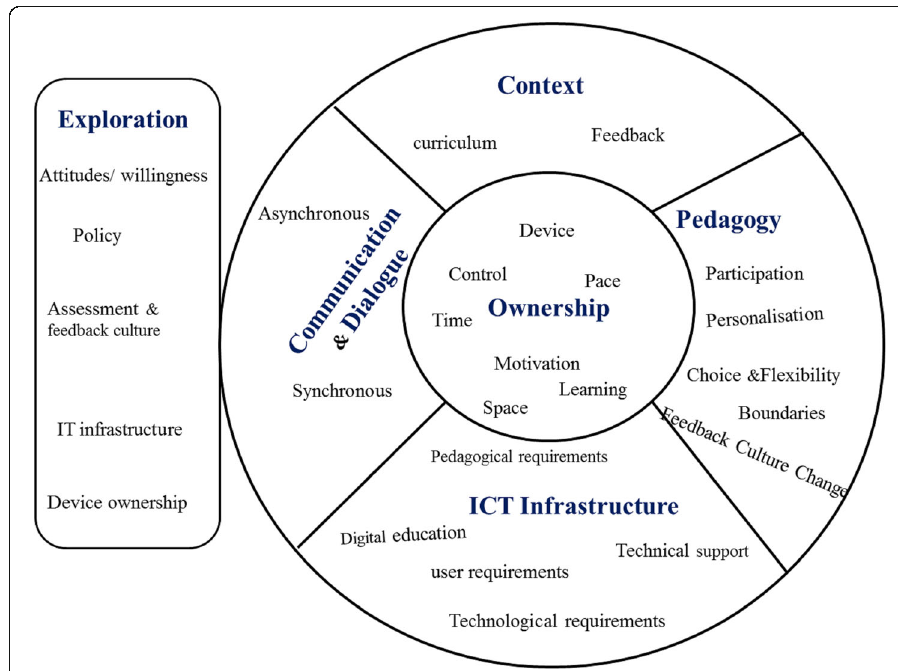
Fig. 2 Mobile Learning Framework for Assessment Feedback based on literature review, fact-finding studies and application development and early